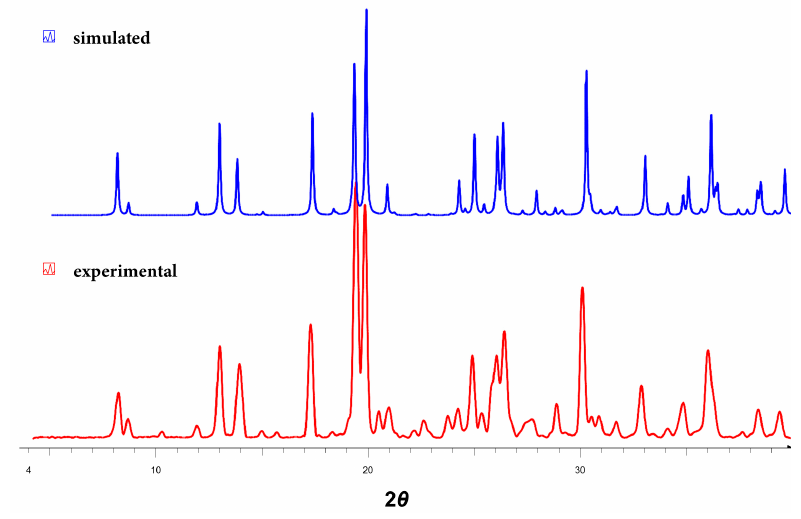
Figure 4. Powder X-ray Diffraction patterns of 3d .